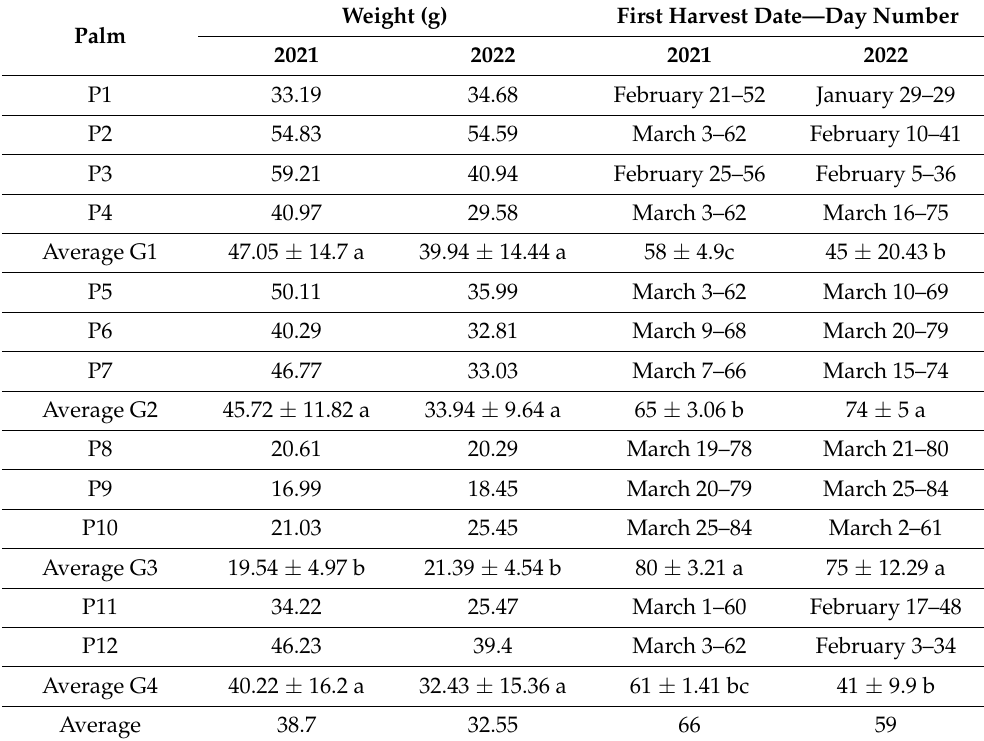
Table 4. Average pollen production of the first four male inflorescences that appeared on each seedling date palm